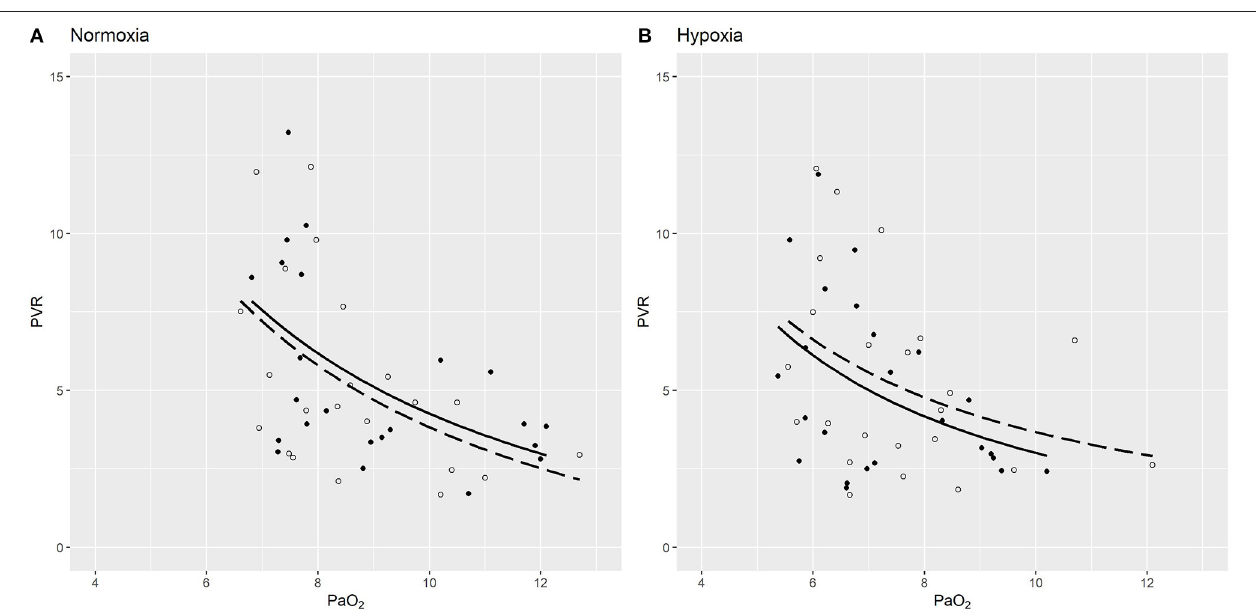
FIGURE 3 | PVR (WU) plotted against PaO 2 (kPa) dependent on treatment (acetazolamide vs. placebo) under normoxia (A) and hypoxia (B) . The light circles depict values under placebo saline treatment, while the filled circles show data points under acetazolamide treatment. Hyperbolic function curves (PVR ∼ 1/PaO 2 ) were fitted for placebo (dashed line) and acetazolamide (drawn out line) under each condition. In the hyperbolic mixed model, PVR inversely correlated with PaO2 ( p = 0.006). Under normoxia (A) there was no significant difference in PVR induced by acetazolamide [0.21, 95-CI ( − 0.28 to 0.66), p = 0.354]. However, under hypoxia, a non-significant trend toward lower PVR is suggested in patients with acetazolamide treatment [mean change − 0.41 WU, 95-CI ( − 0.93 to 0.11), p = 0.124), visualized by the downwards curve shift (B)